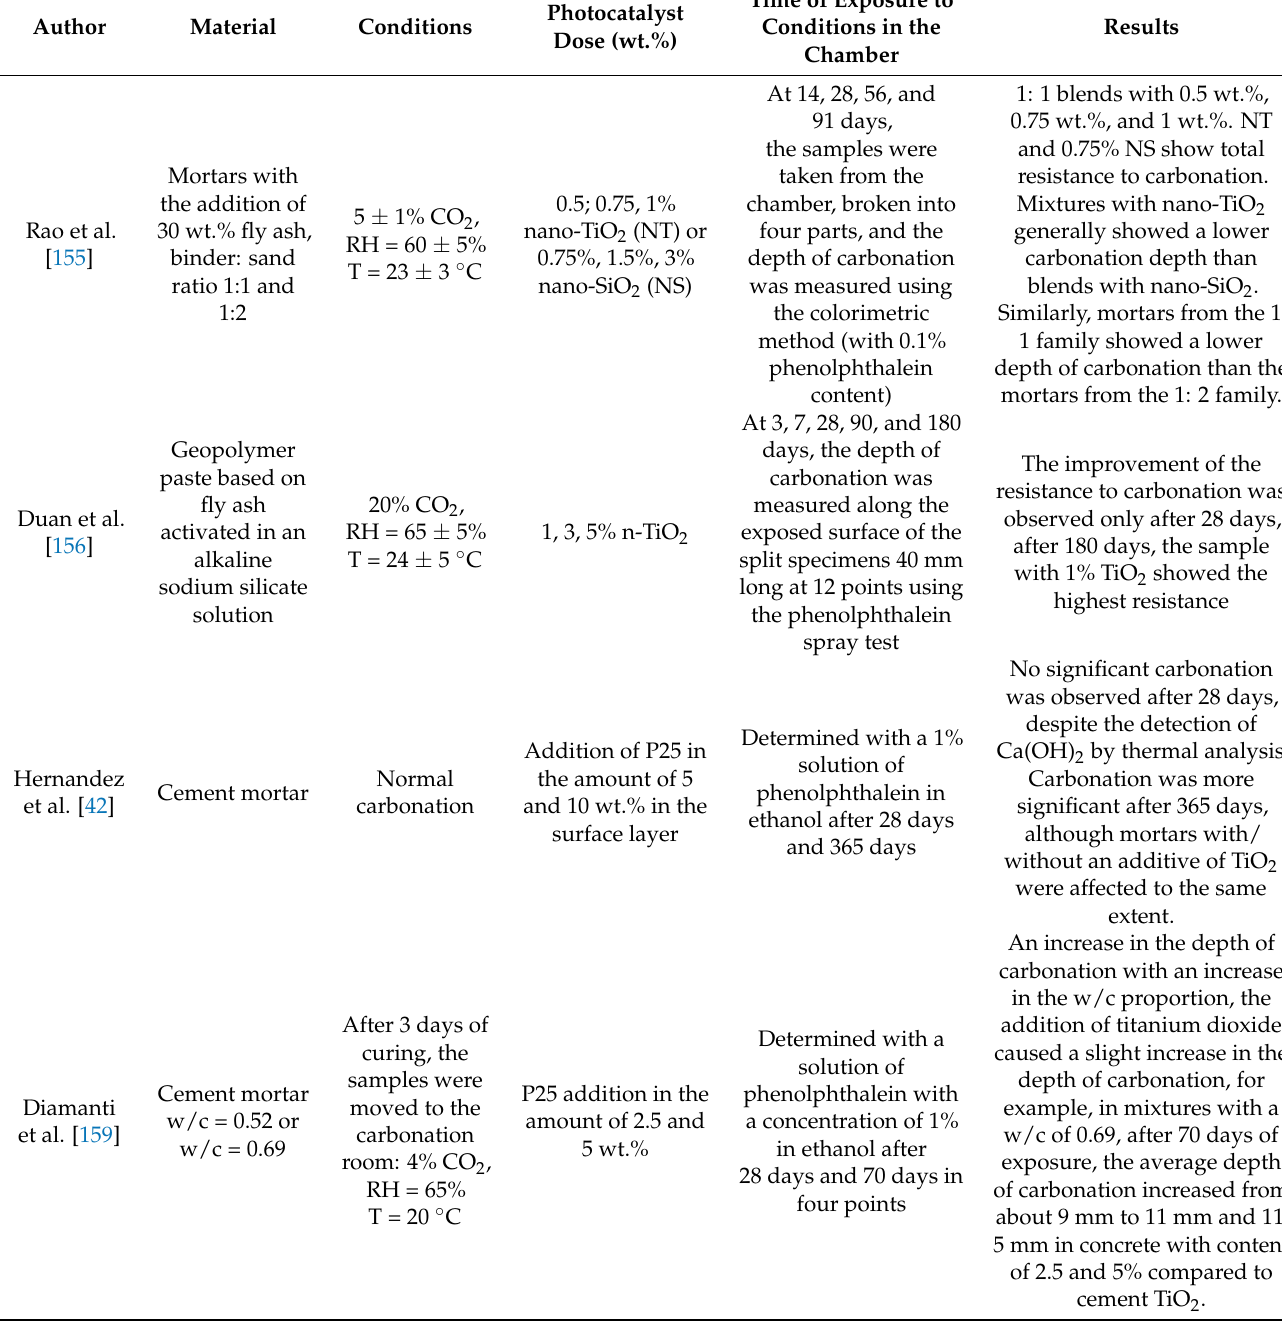
Table 4. Examples of research on the effect of carbonation of photocatalytic cement